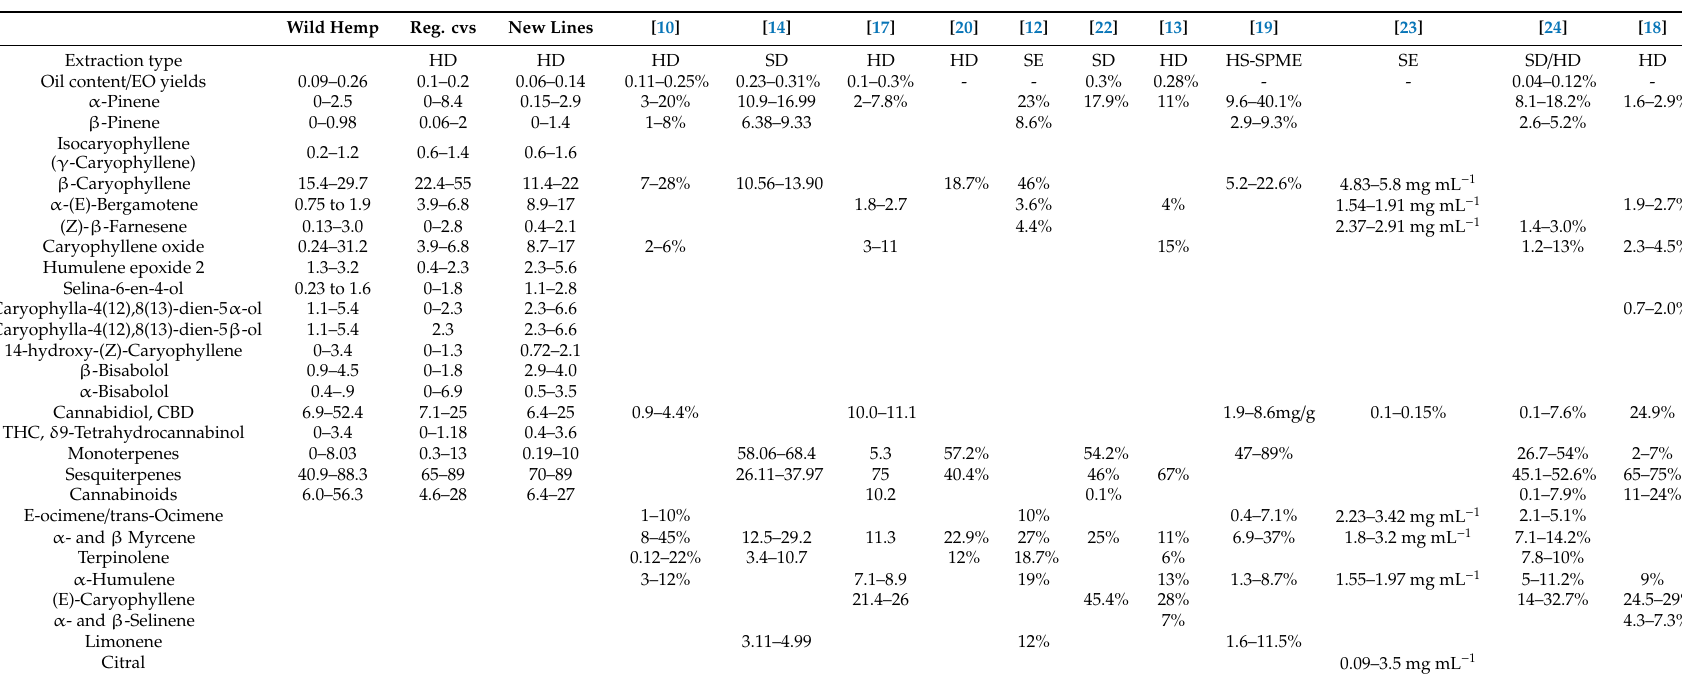
Table 3. Comparative concentrations of essential oil (EO) yield (content, % in biomass) and the concentration of various constituents (% of total oil) in hemp EO from this study and the literature